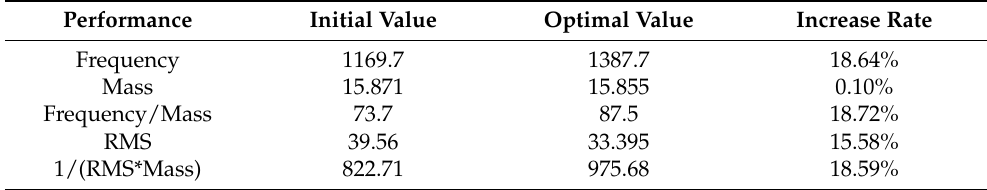
Figure 10. Analysis of the optimized model. ( a ) The first free mode shape; ( b ) Displacement of surface shape (RMS = 33.395 nm). Table 6. Comparison of the performance of the initial mirror and the optimized mirror.